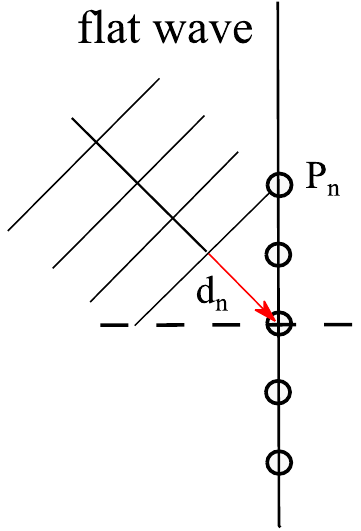
Figure 8. The acoustic beamforming for a plane wave [28].